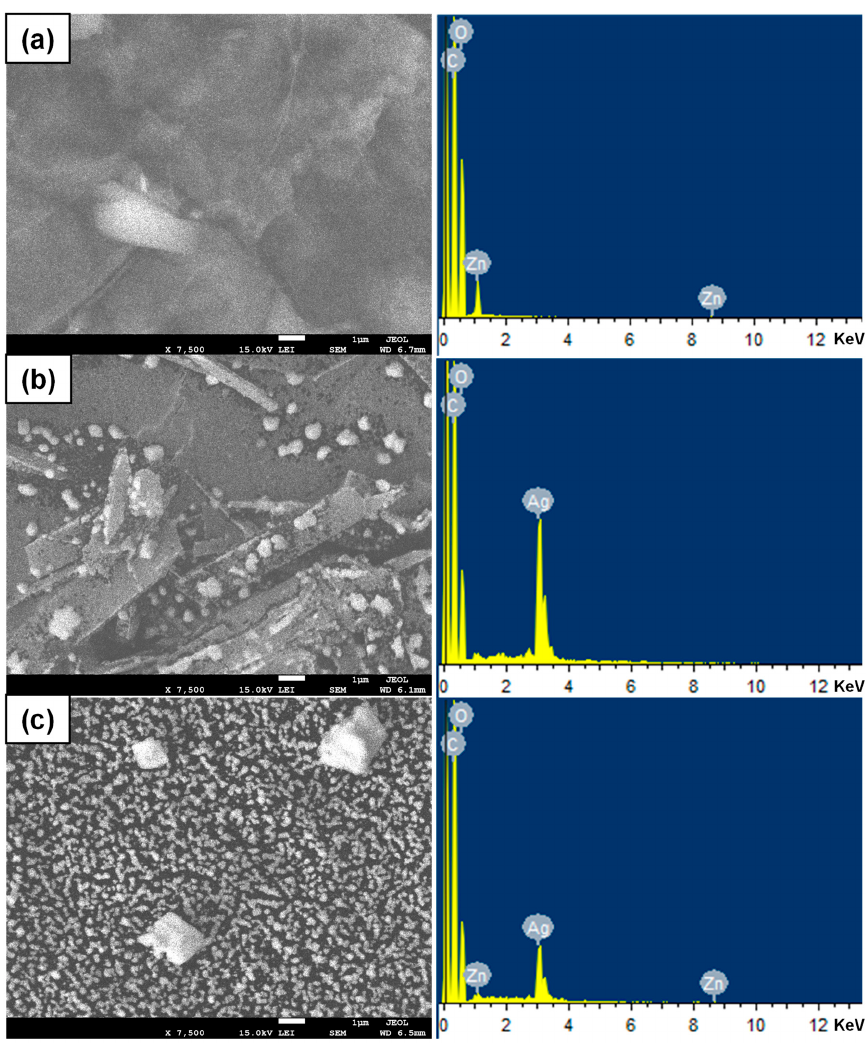
Figure 6. The SEM micrograph and the corresponded EDX spectra of the composite after being coated by ZnO ( a ), Ag ( b ), and their mixture ( c ).